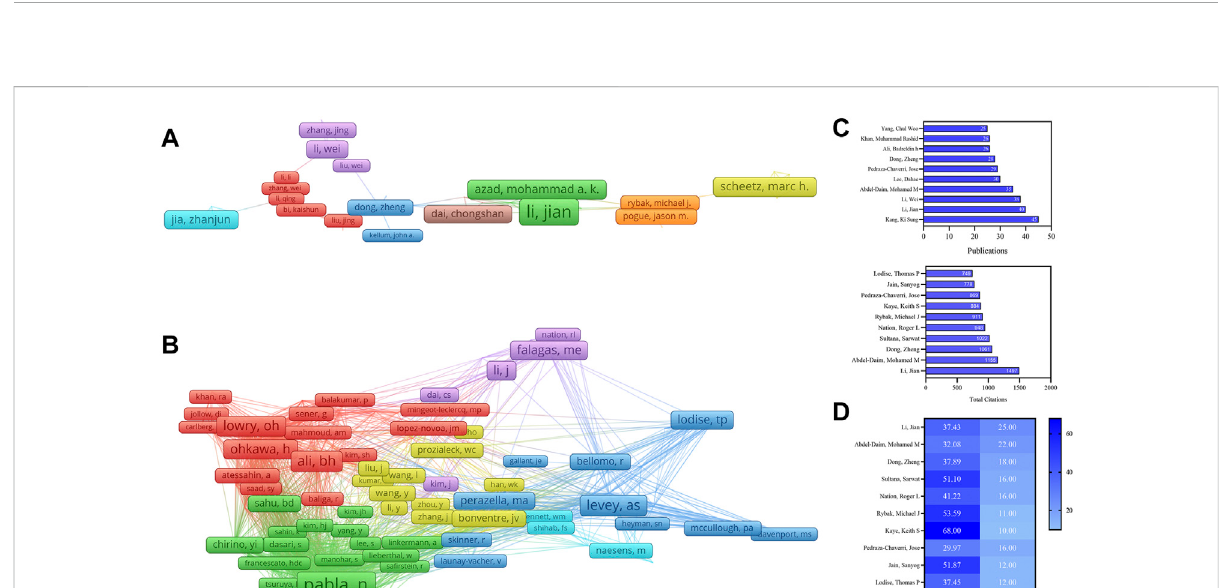
FIGURE 4 VOSviewer visualization map of authors and co-cited authors devoted to nephrotoxicity research. (A) Cooperation network of authors. Of the 47,803 authors, 144 had published at least 10 documents. (B) Co-citation network of authors. Of the 136,917 co-cited authors, 195 had at